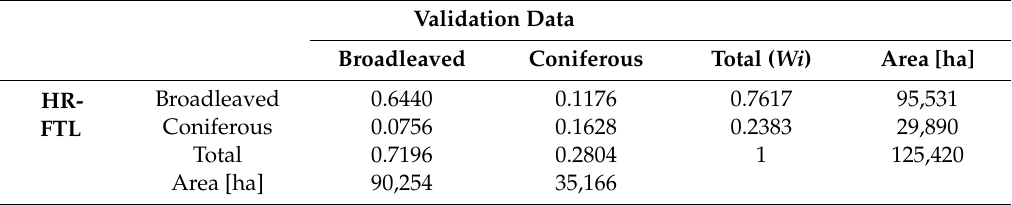
Table 11. Error matrices of estimated proportions of area for the HR-FTL in the Saarland.